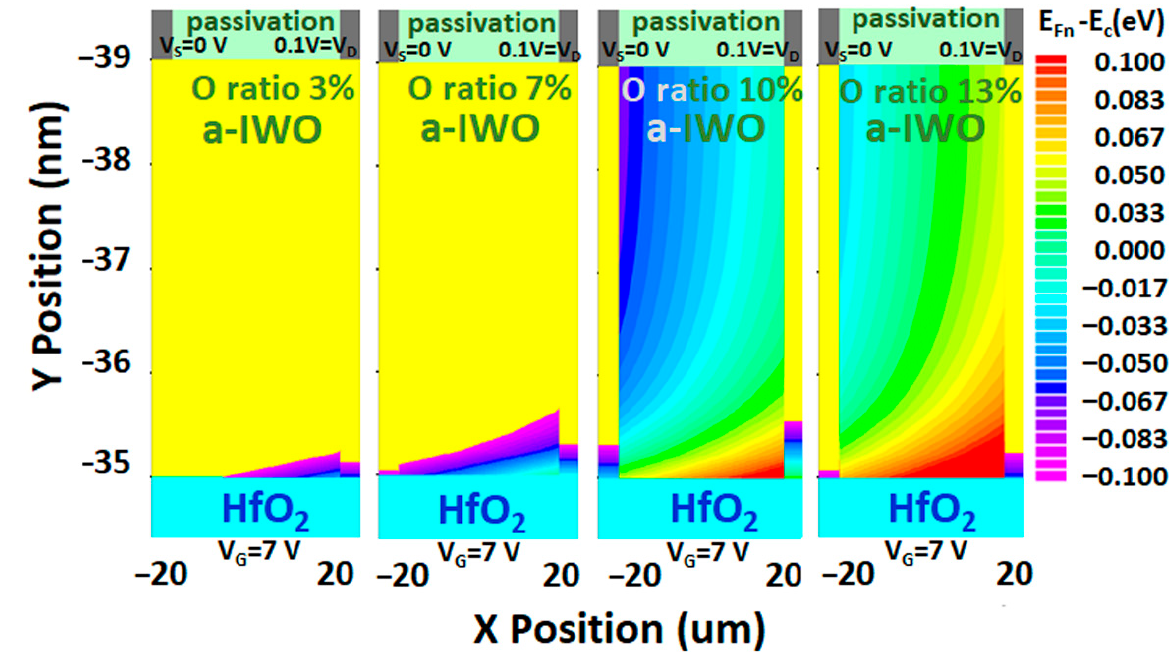
Figure 7. The 2D high Fermi level ( E F ) distributions as a function of bias condition for possible distributions of formed oxygen interstitial (O i ).